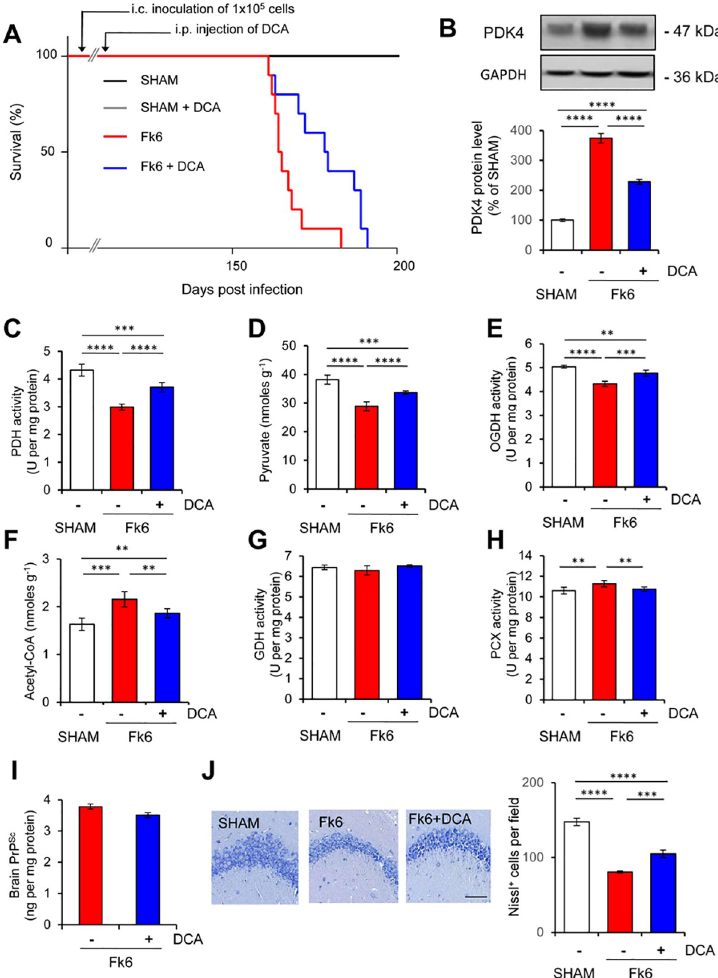
Fig 6. PrP Sc down-regulates PDH activity and glucose oxidative degradation in the hippocampus of prion- infected mice. (A) Survival curves of mock- (SHAM) and prion-inoculated (Fk6) mice via the intracerebral route (i.c.) infused or not with the PDK4 inhibitor DCA by intraperitoneal injection (i.p.) starting 130 d after infection (100 mg per kg body weight per day; 0.25 μ l h -1 , n = 10). (B) Representative western blot and quantification histogram of PDK4 protein expression level in the hippocampus of C57Bl6/J mice infected or not with Fk6 prions infused or not with DCA. GAPDH was used for normalization (n = 6). ( C to H ) PDH activity ( C ), pyruvate amount ( D ), OGDH activity ( E ), acetyl-CoA level ( F ), GDH activity ( G ), and PCx activity ( H ) in the hippocampus of C57Bl6/J mice infected or not with Fk6 prions infused or not with DCA (n = 6). (I) Postmortem quantification of proteinase K-resistant PrP in brains of Fk6-mice infused or not with DCA (n = 10). ( J ) Nissl staining and quantification histogram of viable neurons in the hippocampus of C57Bl6/J mice infected or not with Fk6 prions infused or not with DCA at the end stage of the disease (n = 10). Scale bar = 100 μ m. Data are the mean ± SEM. n.d. not detected. � denotes p < 0.05, �� p < 0.01 and ���� p <